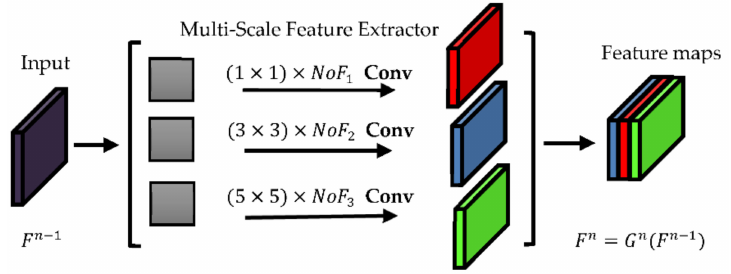
Figure 3. A multi-scale shallow